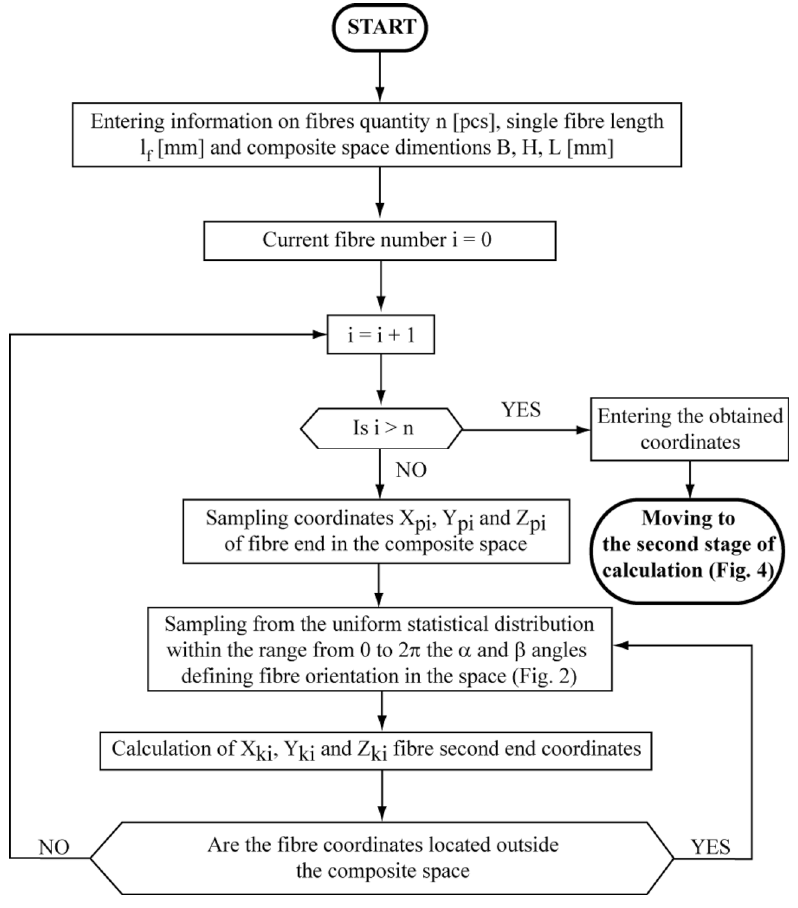
Fig. 1. The algorithm determining fibre orientation in composite space – the first stage of calculation